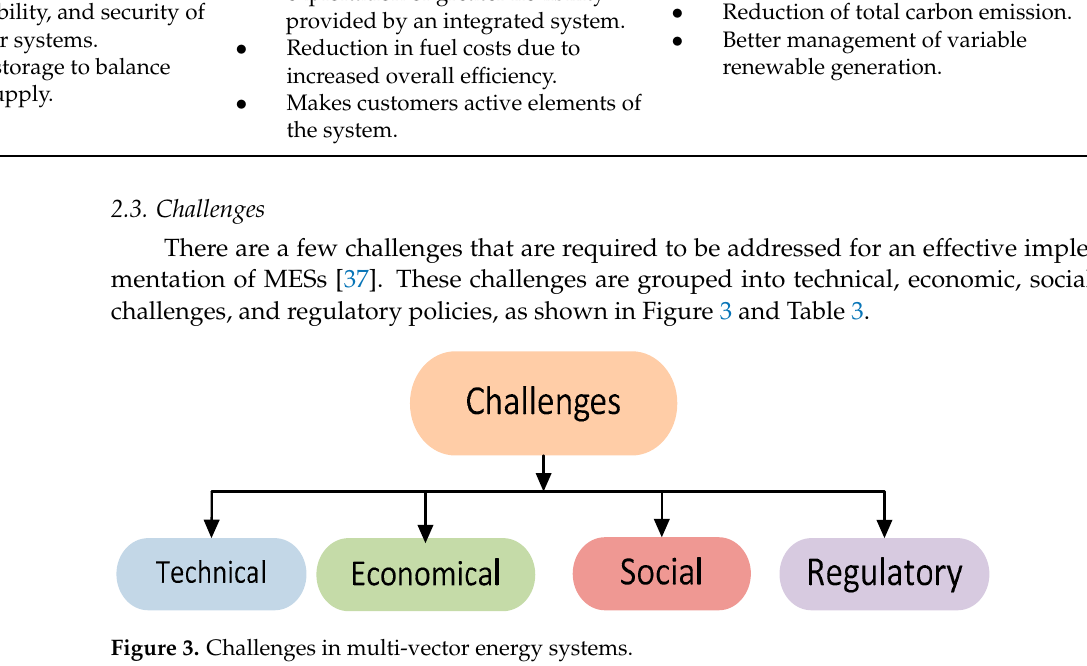
Table 2. Benefits of multi-vector energy systems [49].